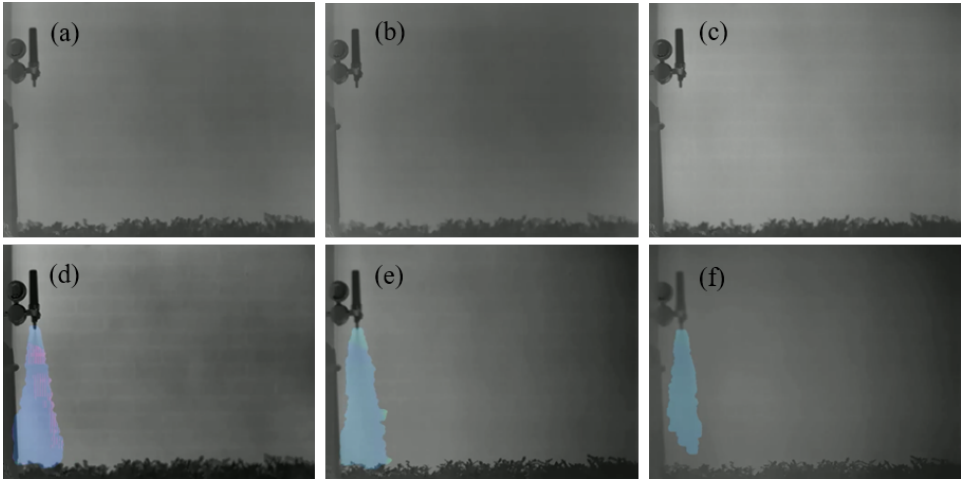
Figure 12. The imaging processing results of ( a ) LP2000 ( b ) LP3750 ( c ) LP4750 ( d ) LP6360 ( e ) LP9000 ( f ) LP10150 of sulfur hexafluoride.